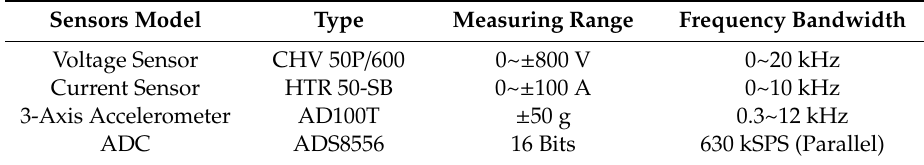
Table 1. Specifications of sensors.